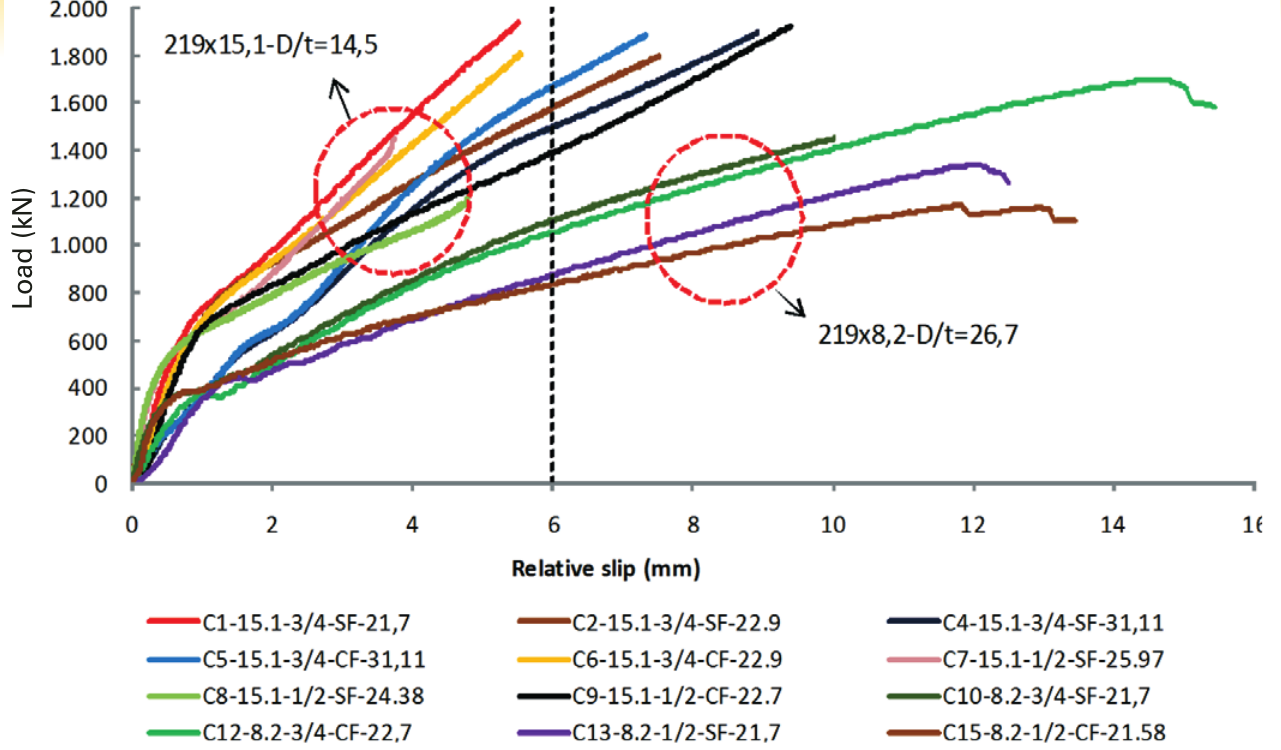
Overriding load curves versus displacement on the series A